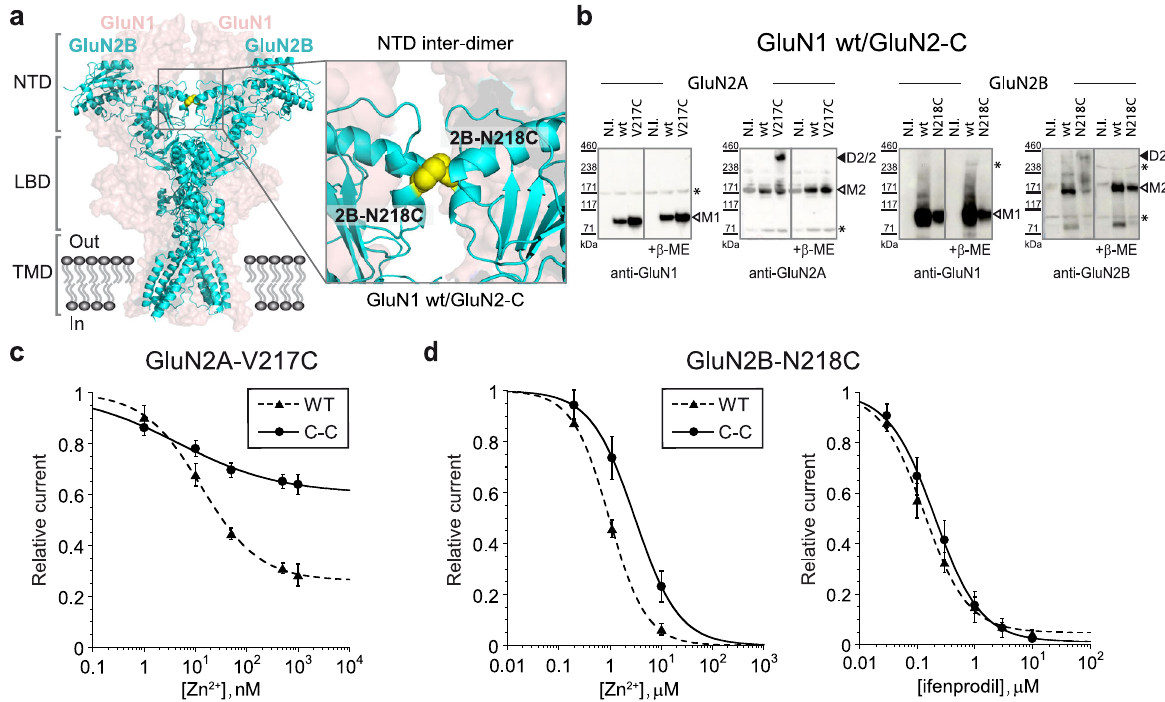
Fig. 4 Restraining NTD inter-dimer conformational mobility differentially affects GluN2A and GluN2B allostery. a Structure of the full-length GluN1/ GluN2B receptors (inhibited state PDB 4PE5, Ref. 10 ) with the location of the engineered cysteine mutation highlighted (yellow spheres). The two GluN2 subunits are shown in cartoon representation while the two GluN1 subunits in the back are displayed in space- fi lled. Inset: enlargement of the region with the pair of cysteines introduced to form a disul fi de bond at the NTD inter-dimer interface made by the two adjacent GluN2 NTD lower lobes. b Immunoblots from Xenopus oocytes expressing GluN1/GluN2A-V217C or GluN1/GluN2B-N218C mutant receptors. Samples were analyzed using anti- GluN1 and anti-GluN2A or anti-GluN2B antibodies. GluN1 monomer (M1) runs at ~110 kDa (M1), GluN2A and GluN2B monomer at ~180 kDa (M2), and GluN2 homodimer at ~360 kDa (D2/2). * indicates non-speci fi c background bands. “ ± β -ME ” indicates immunoblots performed with or without β - mercaptoethanol, i.e., in reducing or non-reducing conditions. N.I. for non-injected oocytes. c Zinc inhibition dose-response curves of GluN1/GluN2A- V217C receptors (C-C, plain line). For comparison, zinc sensitivity of wild-type GluN1/GluN2A receptors (wt, dashed line) is also shown. Values of Zn 2 + IC 50 , maximal inhibition and Hill slope (n H ) are: 4.64 ± 1.78 nM, 0.40 ± 0.03 and 0.44 ± 0.08 ( n = 7 – 13) for C-C; 12.99 ± 1.12 nM, 0.74 ± 0.01 and 0.77 ± 0.05 ( n = 7 – 18) for wt. Data represent mean ± SD. n = number of biologically independent cells. d Zinc (left) and ifenprodil (right) inhibition dose-response curves of GluN1/GluN2B-N218C receptors (C-C, plain lines). For comparison, zinc and ifenprodil sensitivity of wild-type (wt) GluN1/GluN2B receptors are also shown (dashed lines): Values of Zn 2 + IC 50 and Hill slope (n H ) are: 3.06 ± 0.04 μ M and 1.01 ± 0.01 ( n = 5) for C-C vs 0.97 ± 0.03 μ M and 1.20 ± 0.04 ( n = 4) for wt. Values of ifenprodil IC 50 , maximal inhibition and Hill slope (n H ) are: 0.20 ± 0.01 μ M, 0.99 ± 0.02 and 1.08 ± 0.06 ( n = 5 – 15) for C-C; 0.13 ± 0.01 μ M, 0.95 ± 0.02 and 1.14 ± 0.11 ( n = 9 – 16) for wt. Data represent mean ± SD. n = number of biologically independent